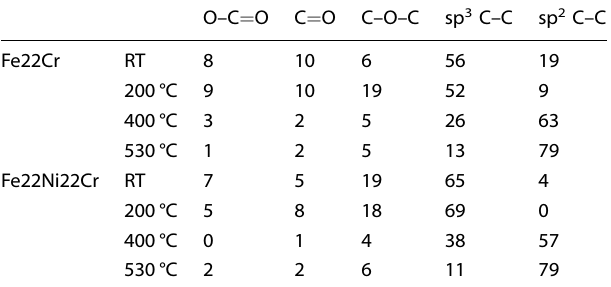
Table 2. C 1s peak fi tting results (% area) for samples exposed to high purity (99.999%) CO 2